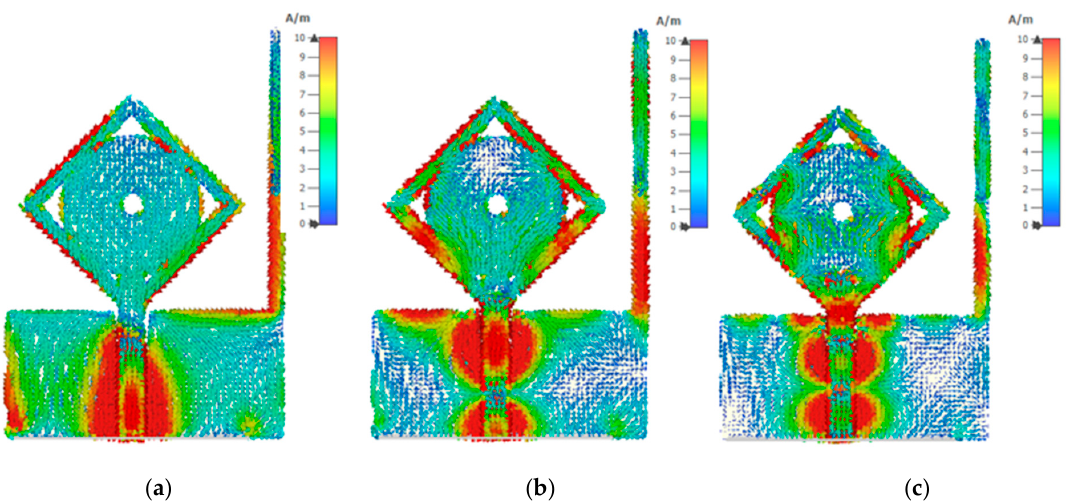
Figure 6. Surface current distribution of the antenna at ( a ) 5 GHz, ( b ) 12 GHz, and ( c ) 20